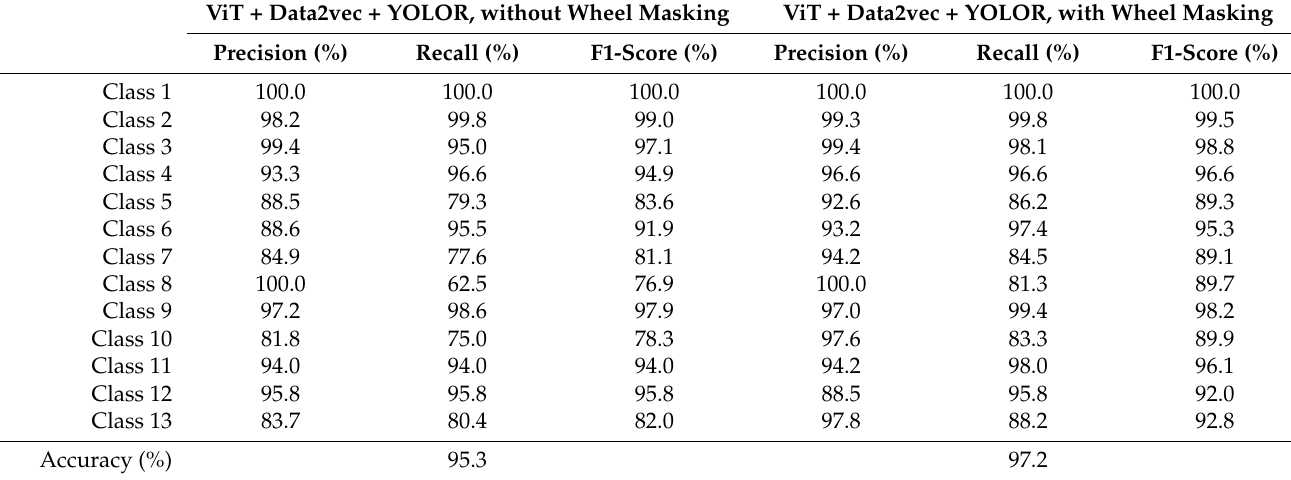
Table 7. Comparison of classification reports of the composite model (ViT + data2vec + YOLOR) with and without wheel